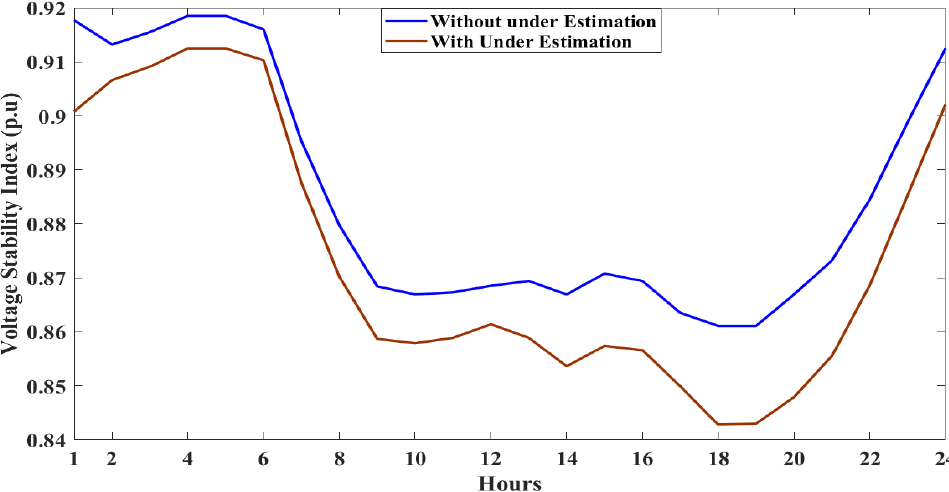
Figure 18. Voltage stability index characteristic comparison with and without underestimation.